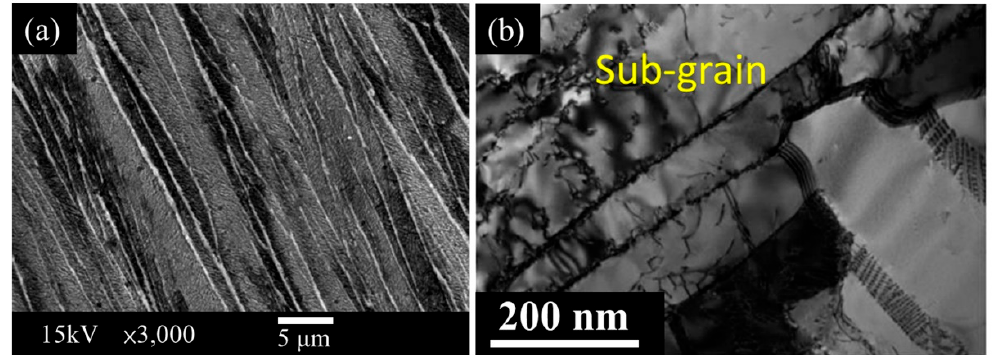
Figure 5. SEM electron micrographs of the specimen annealed at 1040 °C for 24 h. ( a ) SEM image and ( b ) TEM BF image.